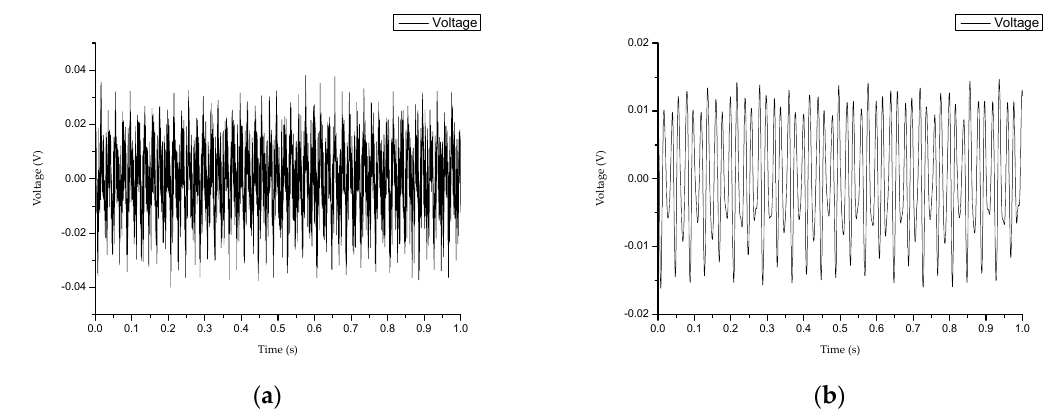
Figure 8. 0 – 1 s original and reconstructed signal: ( a ) original signal; ( b ) reconstructed signal. Table 2. RMSE of ten data segments.